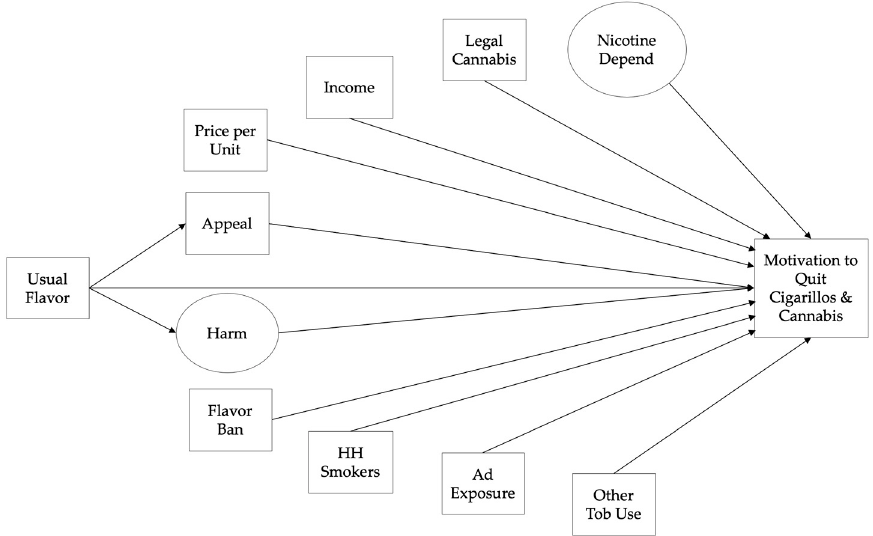
Figure 1. Conceptual Model Diagram (Originally Hypothesized Model): HH = household, Ad = advertising, Tob = tobacco, Depend = dependence.